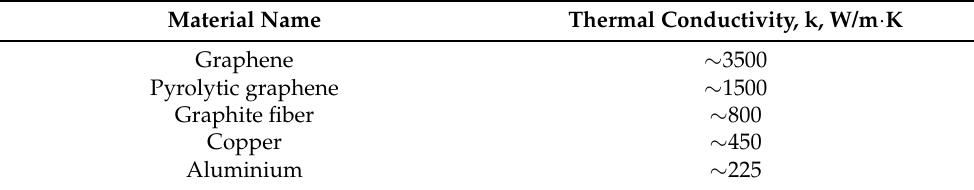
Table 2. Thermal strap